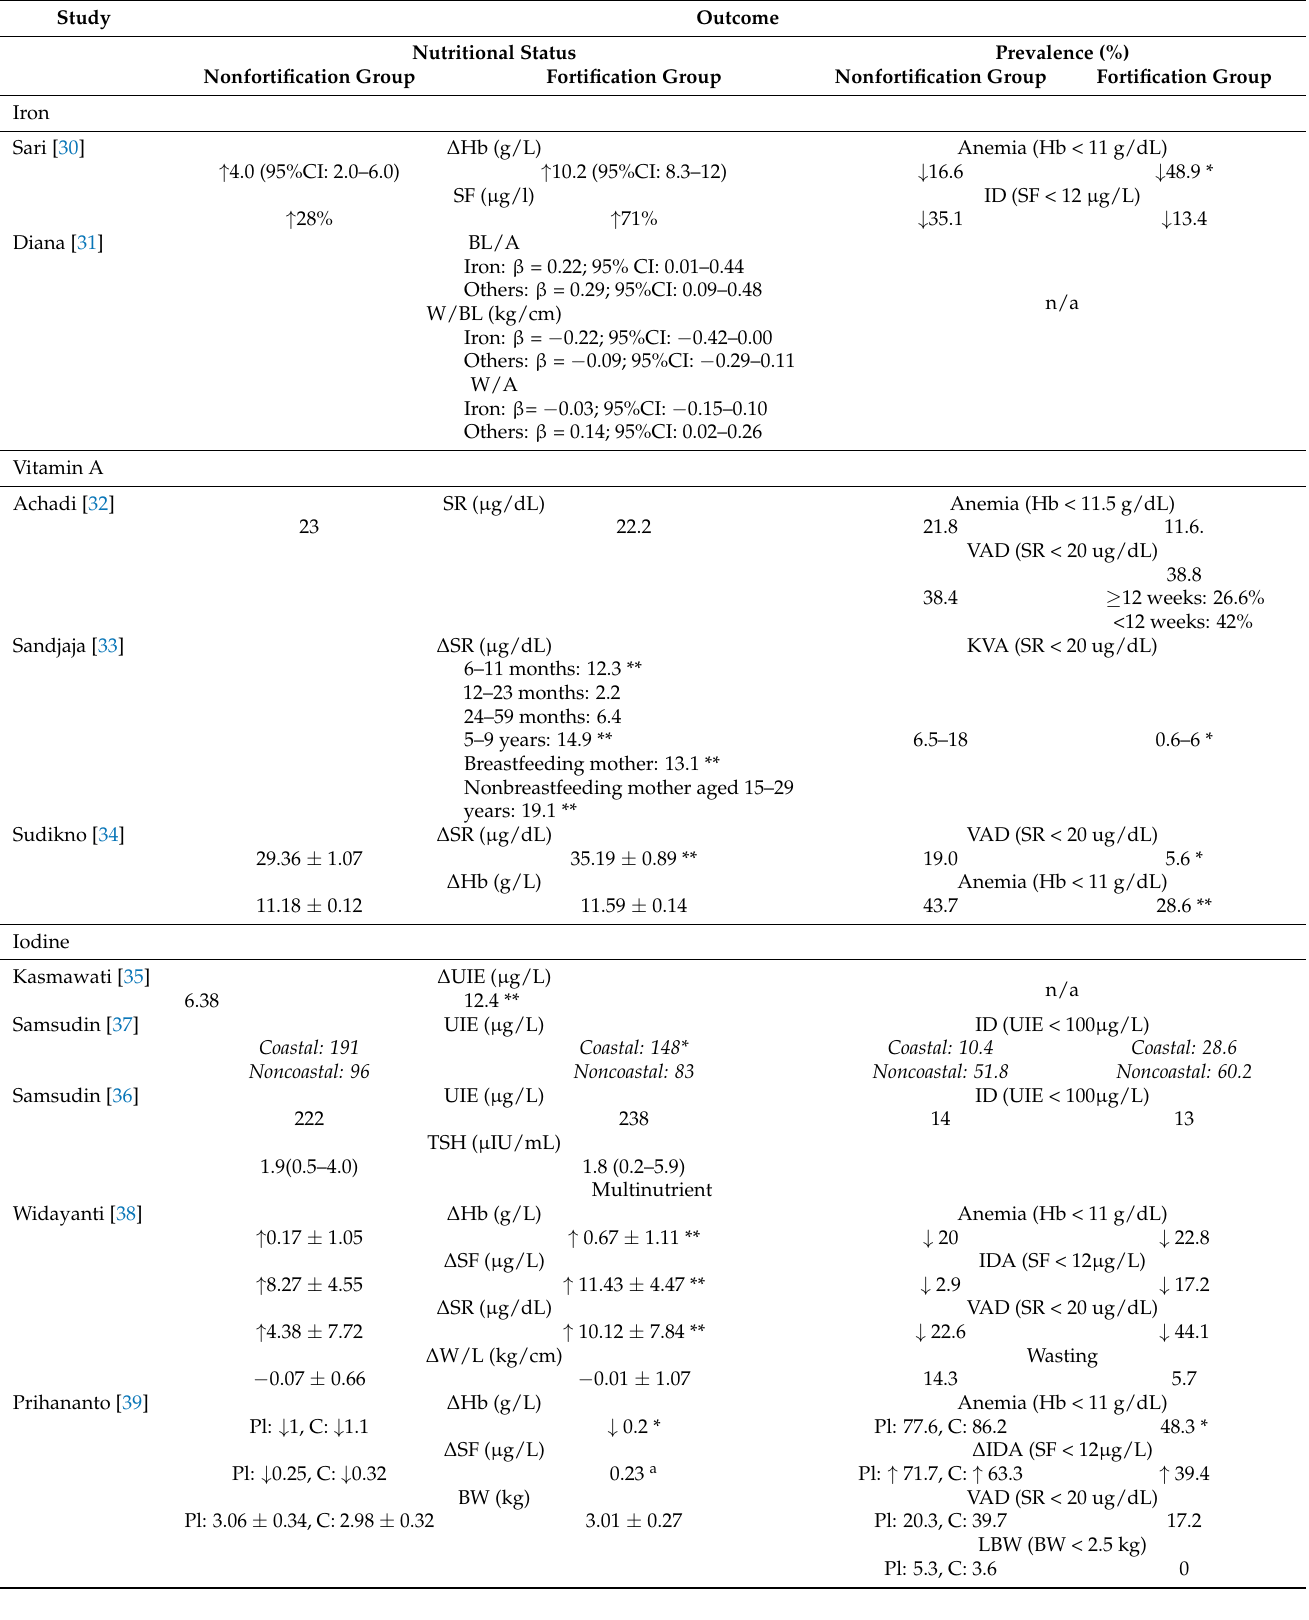
Table 3. Fortification outcome in several